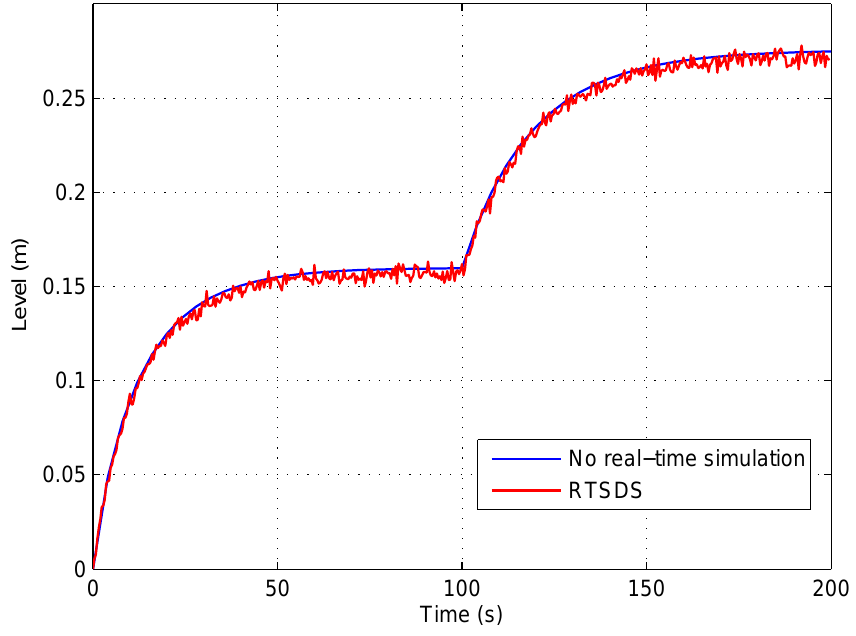
Figure 15. Results obtained for the RTSDS platform applied to the dynamic system characterized by Equation (5), with A = 15 . 518 cm 2 and q q ( t ) = 0 . 6 after 100 s. e